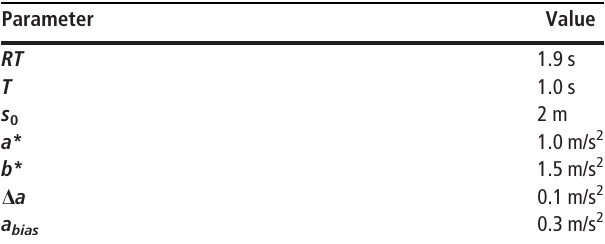
Table I Values of the de fi ned cell